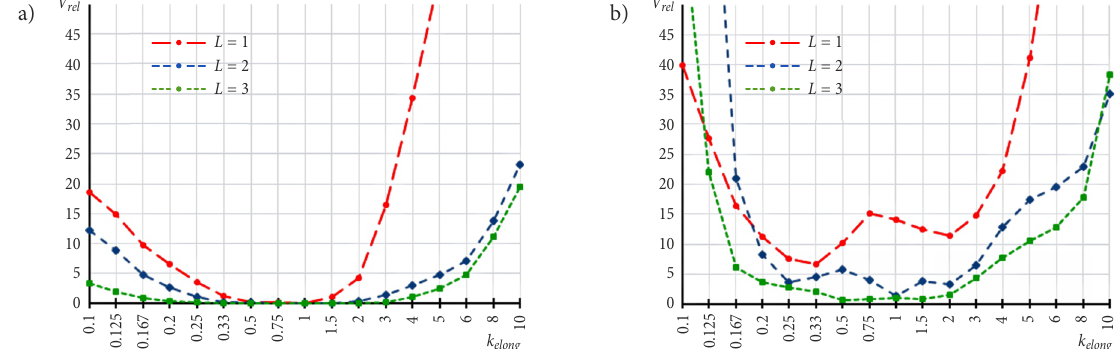
Fig. 3. Variations of square root errors of elongated (flattened) quasi-quadric particles obtained by LRSH with different values of expansion degree L : a) quasi-ellipsoids; b)